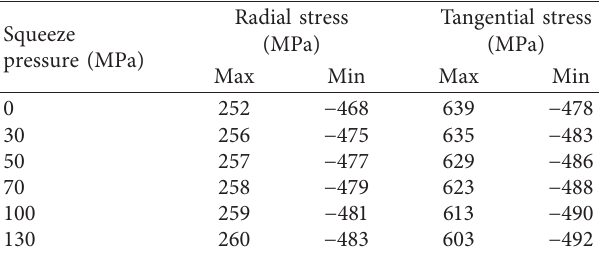
Table 6: Stress dispersion of the squeeze cast composite for 800